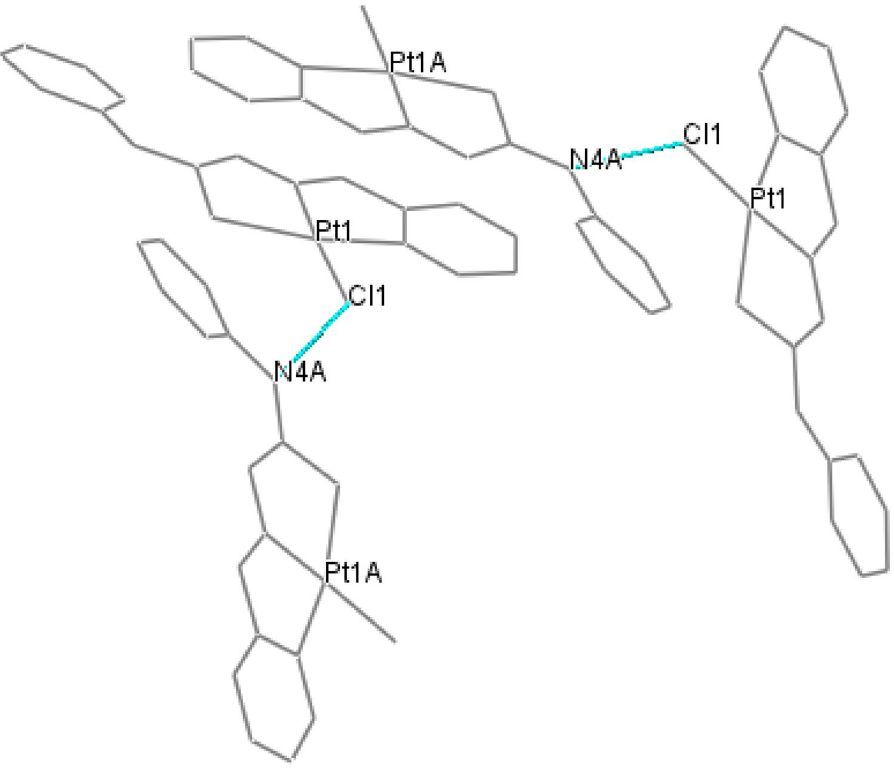
Figure 2. Hydrogen bonding between adjacent molecules of neighboring asymmetric unit cells.